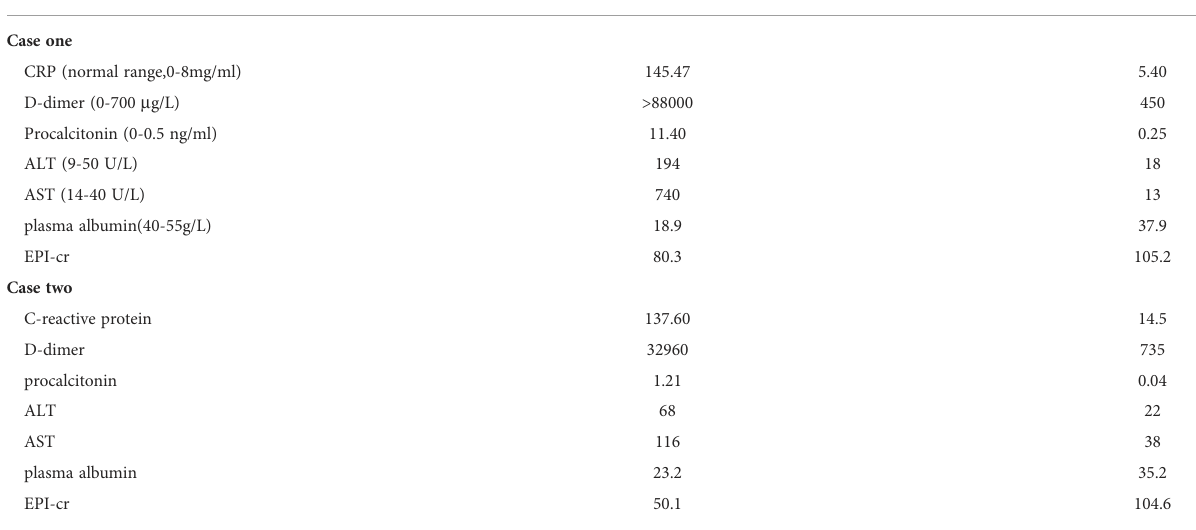
TABLE 1 Laboratory parameters before and after ruxolitinib